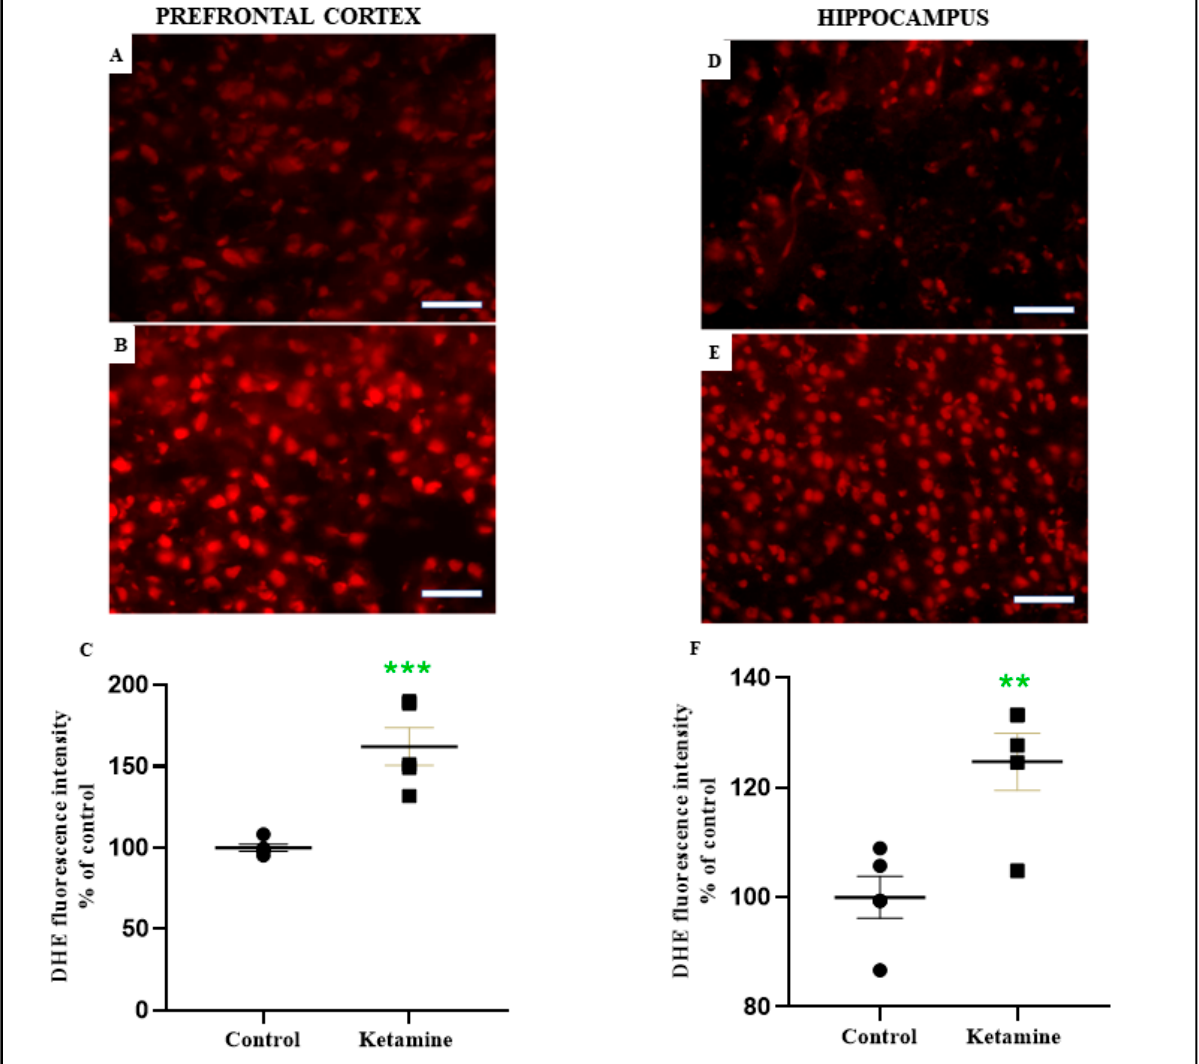
Figure 6. Effects of ketamine recreational regimen (10 mg/kg/day for 3 days, i.p) or saline (control group) in the early withdrawal (24 h) on reactive species oxygen (ROS) levels on prefrontal cortex and hippocampus of adolescent female Wistar rats ( n = 5 animals/group). i. Representative fluorescence microscope photomicrographs of prefrontal cortex ( A , B ) and hippocampus ( D , E ) sections, incubated with dihydroethidium (DHE) probe. Red fluorescence reflects ROS production. ii. Quantification of DHE fluorescence intensity on prefrontal cortex ( C ). iii. Quantification of DHE fluorescence intensity on hippocampus ( F ). Results were expressed as percentual of the control group. *** p < 0.01 compared to control group; ** p < 0.0001 compared to control group. Mann–Whitney test. Scale bar: 50 µm.